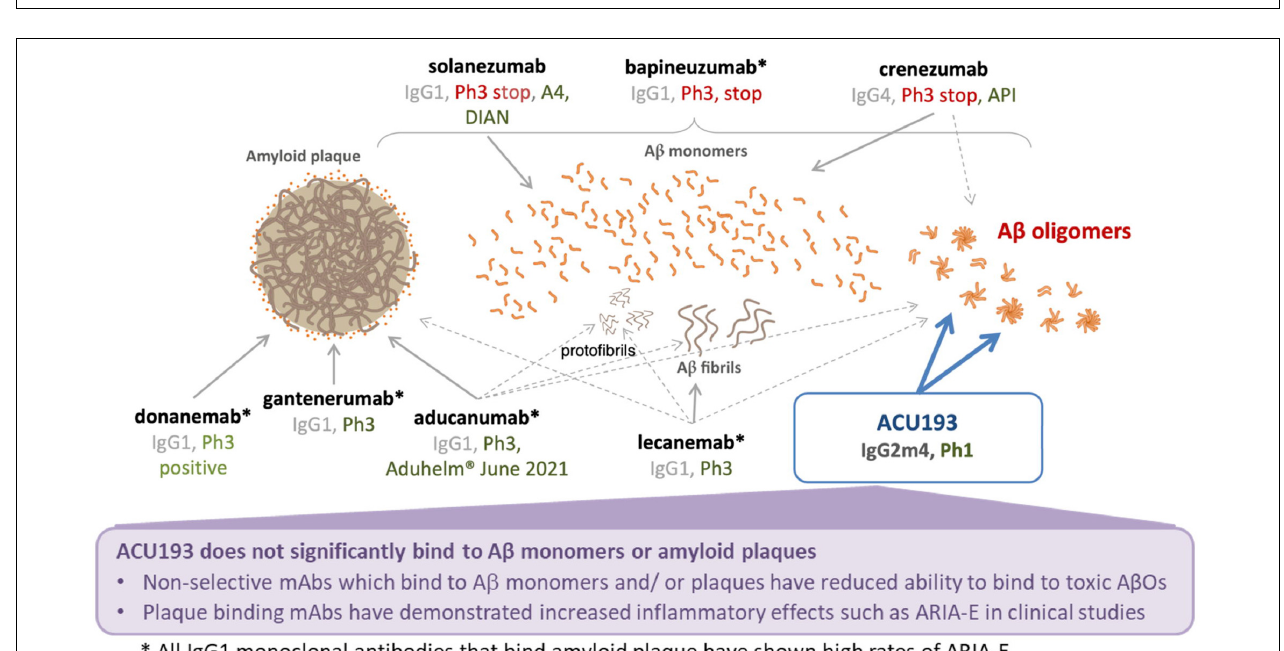
FIGURE 2 | Summary comparison of ACU193 to amyloid-directed therapeutic antibodies in clinical development.